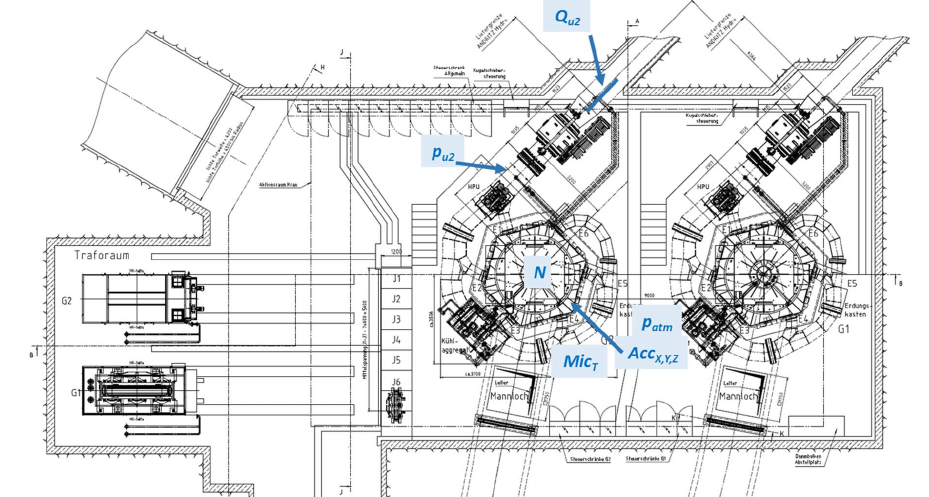
Figure 10. Locations of the various sensors around the Pelton turbine of group 2 with Acc x , y , z as the three axis accelerometer, Mic T as the microphone, N as the tachometer, P atm as the pressure sensor in the power plant house, P u 2 as the pressure sensor set at the inlet of the manifold, and Q u 2 as the flow-meter.